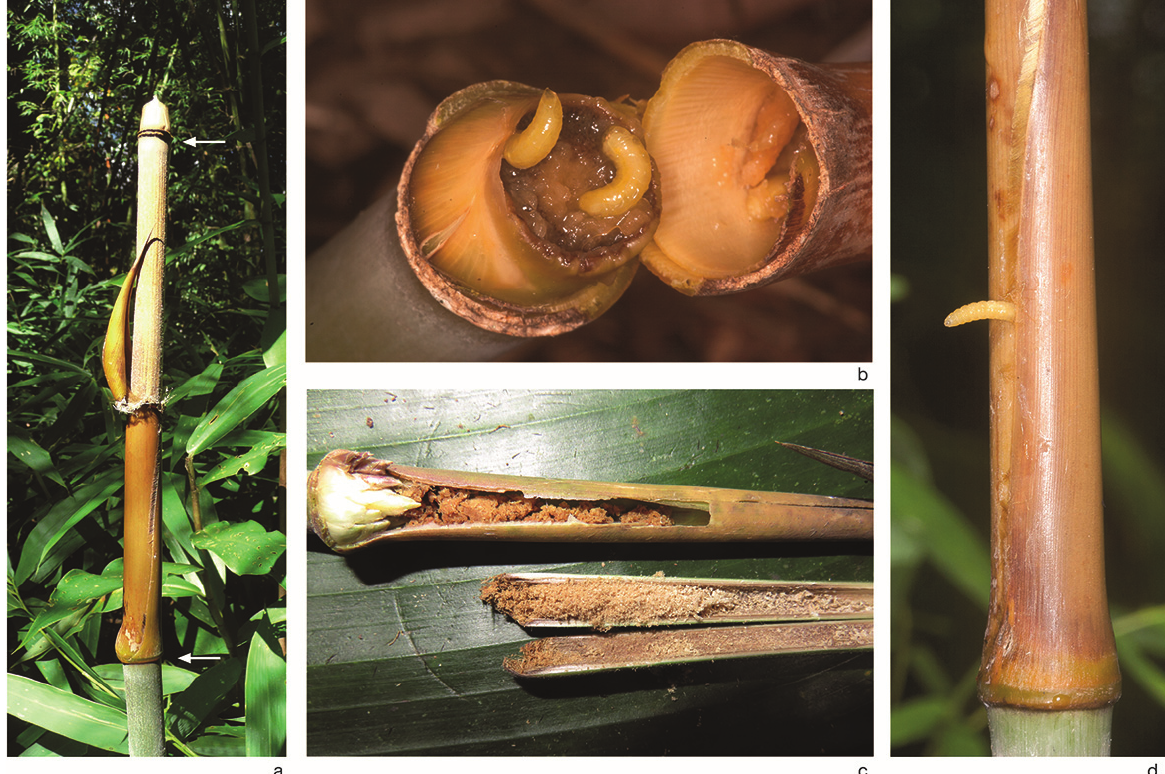
Figure 3. Larval habitat and feeding traces of A. rufipes . ( a ) Infested internode of C. pergracile , which was located on the top of a bamboo shoot, ca . 8 m above the ground. The lower half of the internode, where the larvae feed, is enclosed by the stiff and tight culm sheath. White arrows indicate the upper and lower end of the internode; ( b ) Larvae of A. rufipes (culm sheath broken off); ( c ) Feeding traces of A. rufipes in a small internode. The basal part of the internode wall was entirely devoured (internode pulled out, sheath and internode cut open). Note the yellow-green brunch bud at the base of the internode (left); ( d ) A. rufipes larva leaving the internode by squeezing its way between the overlapping culm